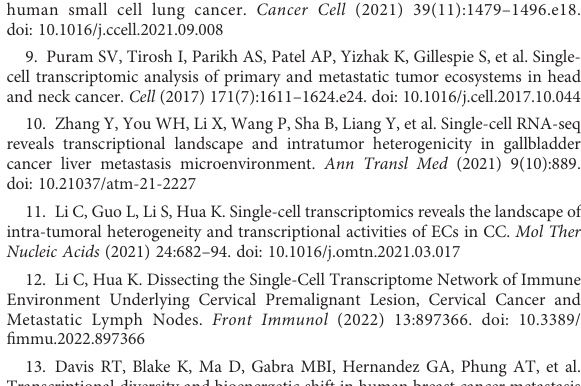
SUPPLEMENTARY FIGURE 5 Survival analysis of mesenchymal and epithelial markers according to TCGA data. SUPPLEMENTARY FIGURE 6 Comparison of cellnumber, geneexpression, andfunctional status ofNK/ T cells between metastatic tumor (tumor 3) and non-metastatic tumors (tumors 1 and 2). The difference in cell number of NK/T cells between metastatic tumor (tumor 3) and non-metastatic tumors (tumors 1 and 2) (A) . Volcano plot showing differentially expressed genes of NK/T cells between metastatic tumor (tumor 3) and non-metastatic tumors (tumors 1 and 2) (B) . GO analysis of upregulated genes of NK/T cells in non- metastatic tumor (C) . GO analysis of upregulated genes of NK/T cells in metastatic tumor (D) . SUPPLEMENTARY FIGURE 7 GO analysis of up-regulated genes in nine macrophage clusters. SUPPLEMENTARY FIGURE 8 Comparison offunctional status of macrophages among different groups. GO analysis of up-regulated genes of macrophage in non metastatic tumor (A) . GO analysis of up-regulated genes of macrophage in metastatic tumor (B) . Comparison of M2- and M1-signature score between metastatic tumor (tumor 3) and non-metastatic tumors (tumor 1 and 2) (C) . GO analysis of up-regulated genes of macrophage in P-LN (D) . GO analysis of up-regulated genes of macrophage in N-LN (E) . The comparison of M2- and M1-signature score between P-LN and N-LN (F) . SUPPLEMENTARY FIGURE 9 GO analysis of up-regulated genes in six CAF clusters. SUPPLEMENTARY FIGURE 10 Comparison of functional status of CAFs among different groups. GO analysis of up-regulated genes of CAFs in non-metastatic tumor (A) . GO analysis of up-regulated genes of CAFs in metastatic tumor (B) . GO analysisofup-regulated genesof CAFsin P-LN (C) . GOanalysisofup- regulated genes of CAFs in N-LN (D)